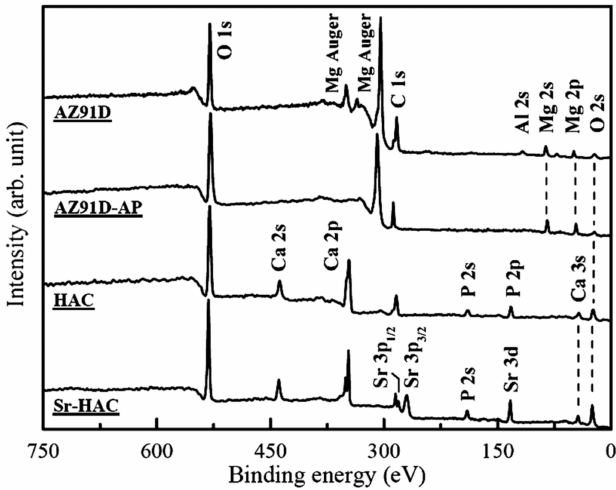
Figure 2. XPS survey spectra analysis for the AZ91D alloy, AZ91D-AP, HAC, Sr-HAC